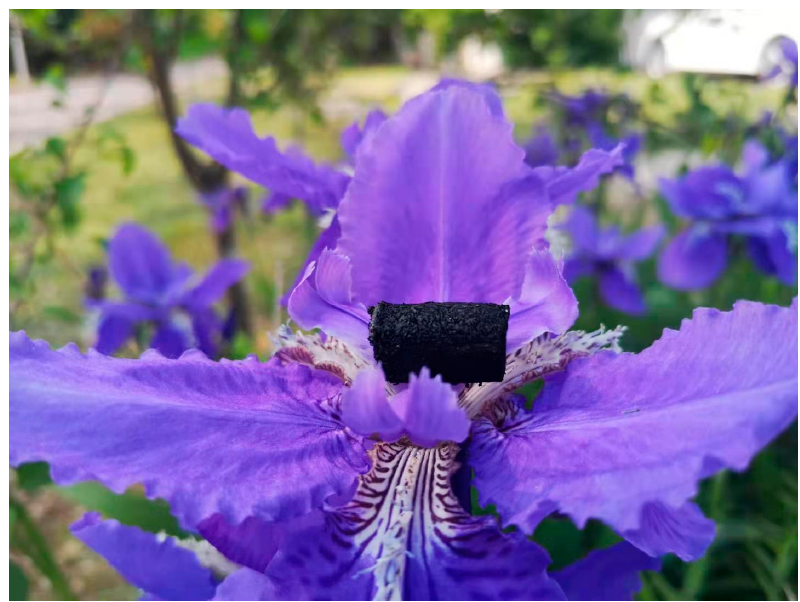
Figure 2. Graphene oxide aerogel easily supported by flowers.